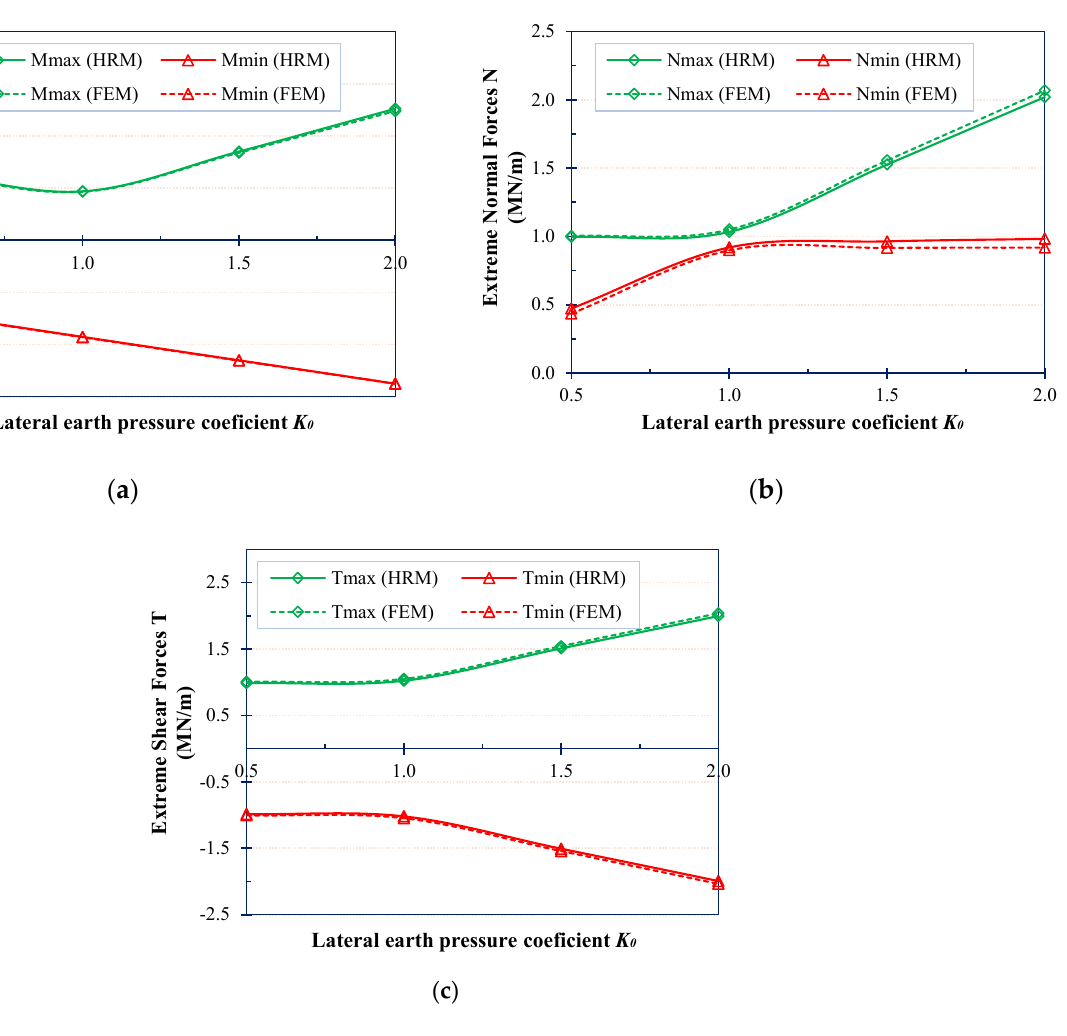
Figure 9. Effect of K 0 on the internal forces in the squared tunnel lining: ( a ) Extreme bending moments M; ( b ) Extreme normal forces N; ( c ) Extreme shear forces T.